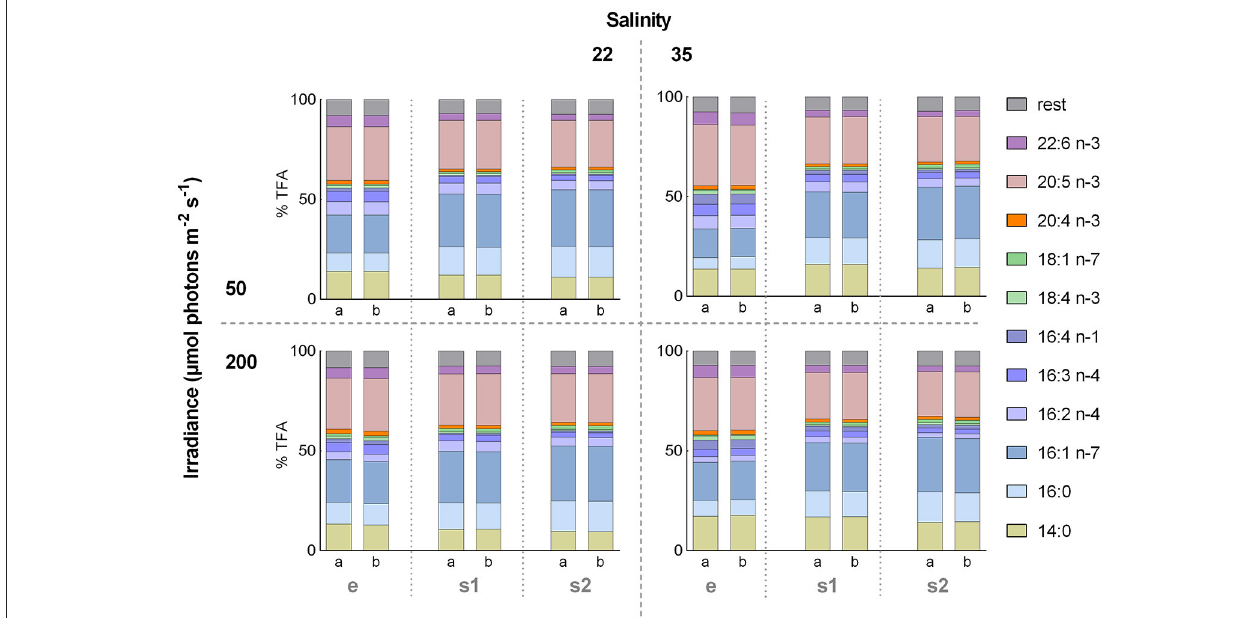
FIGURE 4 | Relative fatty acid (FA) composition during factorial-design batch experiment . Effect of the 12 different treatments on the relative FA composition (% of total fatty acids [TFA]) of the diatom Attheya septentrionalis (each with two biological replicates, a and b). Treatments were altering combinations of the three factors salinity (22 and 35), irradiance (50 and 200 µ mol photons m − 2 s − 1 ) and growth phase (exponential [e], 3 days stationary phase [s1], and 5 days stationary phase [s2]). Values are average of three measurement replicates.